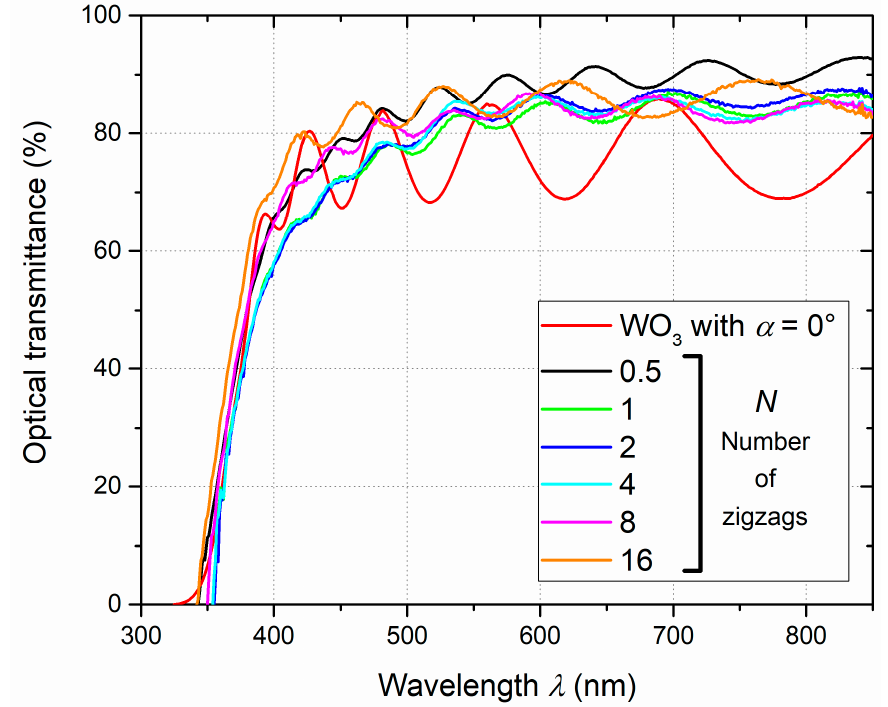
Figure 3. Optical transmittance spectra in the visible range of 1 µm thick WO 3 zigzag thin films